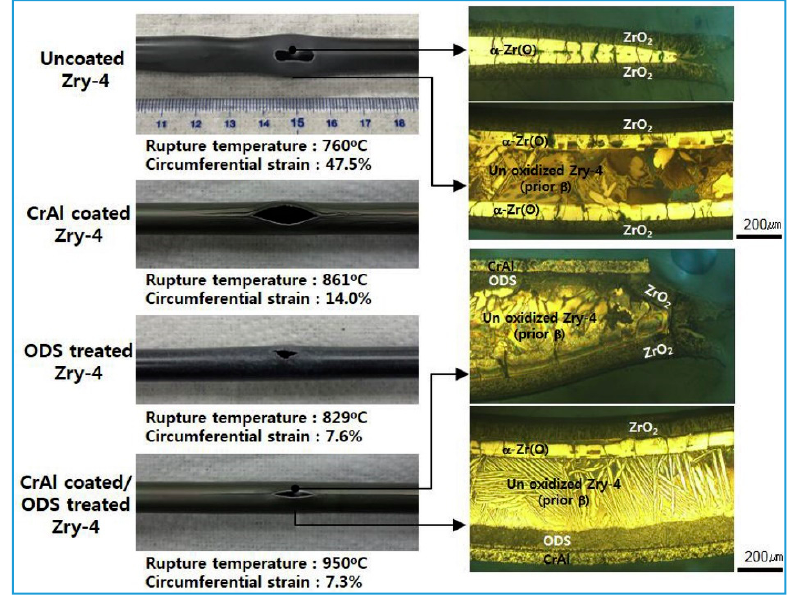
Figure 14. The comprehensive LOCA test on the Zr cladding coated with both the CrAl layer and the ODS layer. Reproduced from the work in [50] with copyright permission from Elsevier.